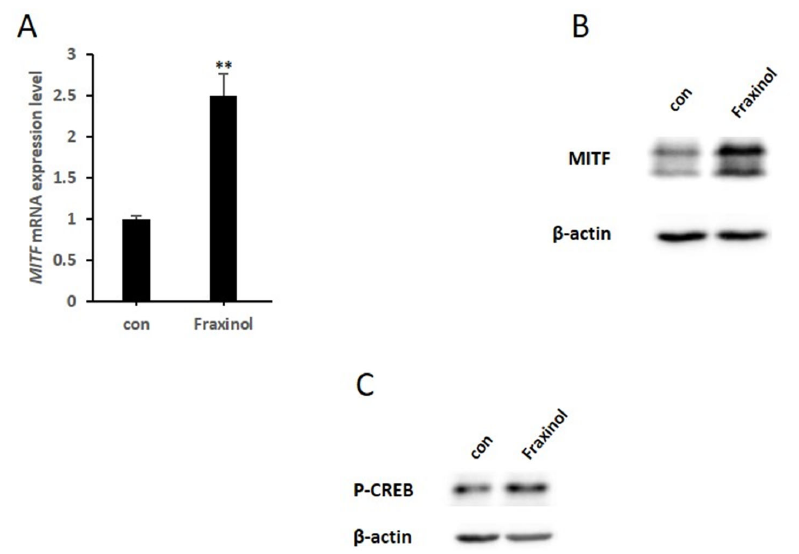
Figure 4. Effects of fraxinol on mRNA and protein expression of MITF and phosphorylation of CREB. B16F10 cells were treated with fraxinol (100 μ M). ( A ) MITF mRNA expression was detected using qRT ‐ PCR at 12 h after fraxinol treatment. ( B ) MITF protein expression was detected using western blotting at 24 h after fraxinol treatment. ( C ) Expression level of phosphorylated CREB was examined using western blotting at 4 h after fraxinol treatment. The data are presented as the means ± SD; n = 2. ** p < 0.01 compared to control (no treatment).